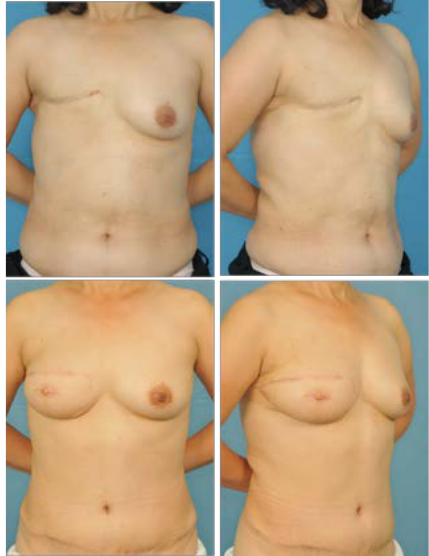
Figure 8. A 50-year-old patient who underwent delayed reconstruction with partial rectus muscle